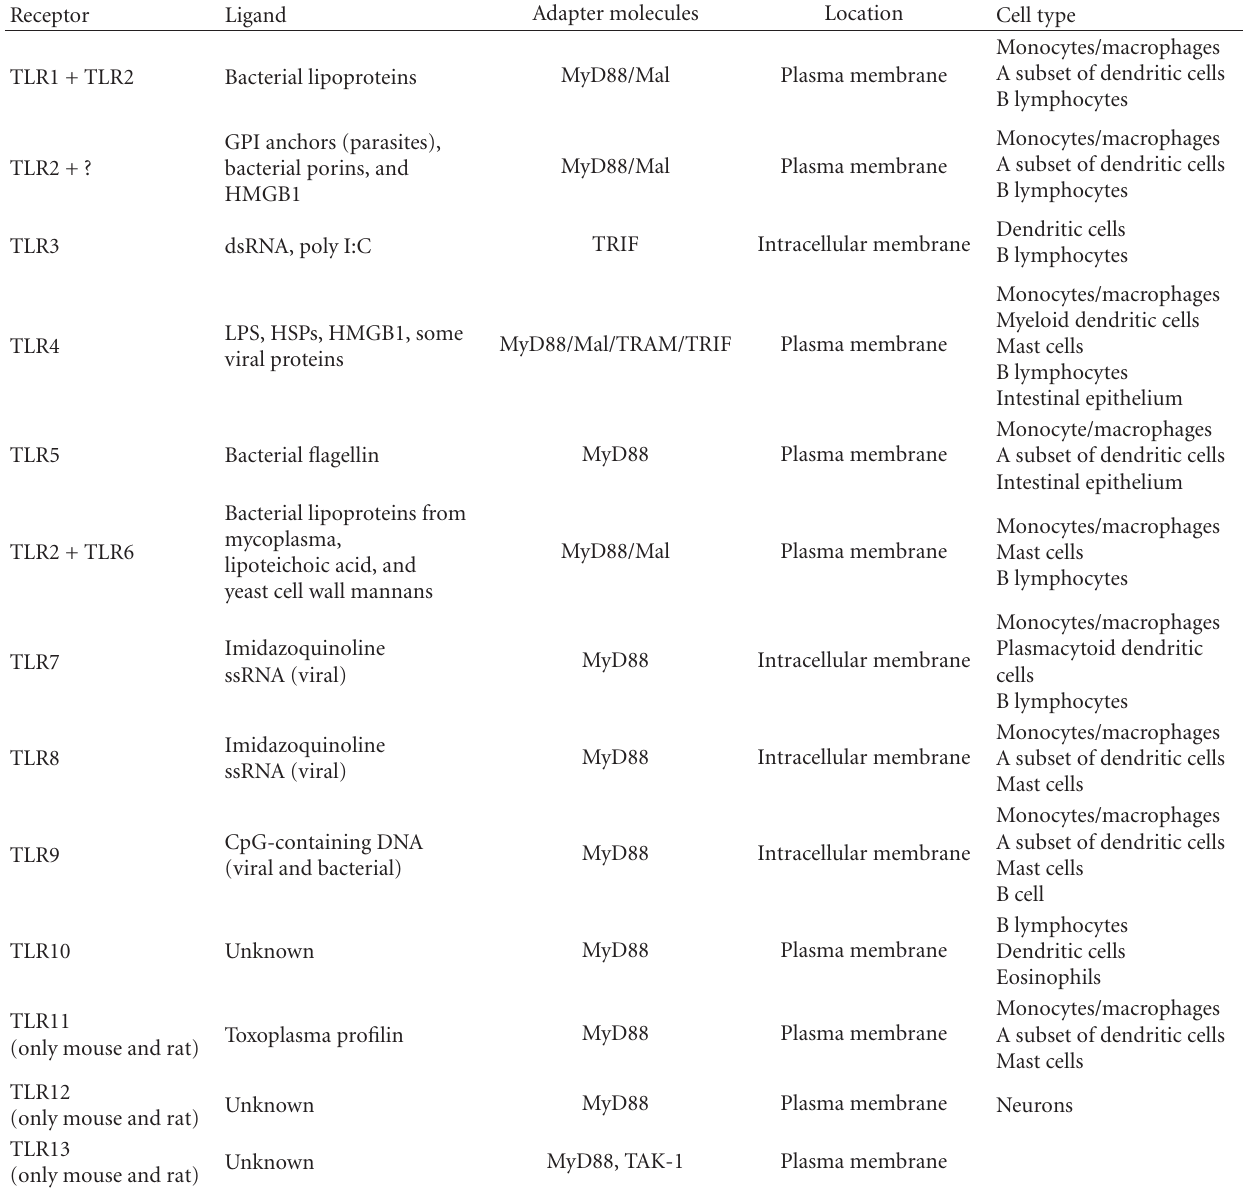
Table 3: The classification of TLR